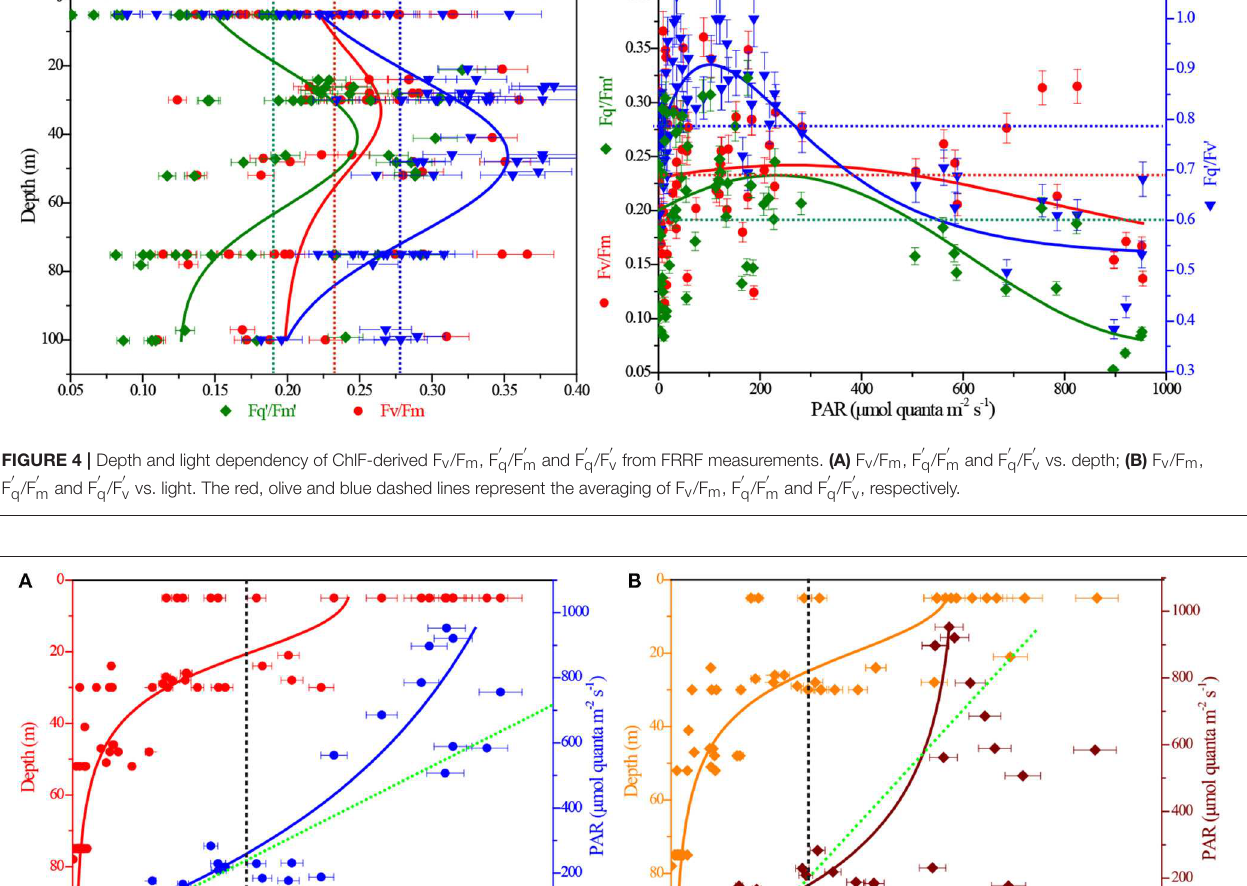
varied by 2 orders of magnitude across the BOB, from